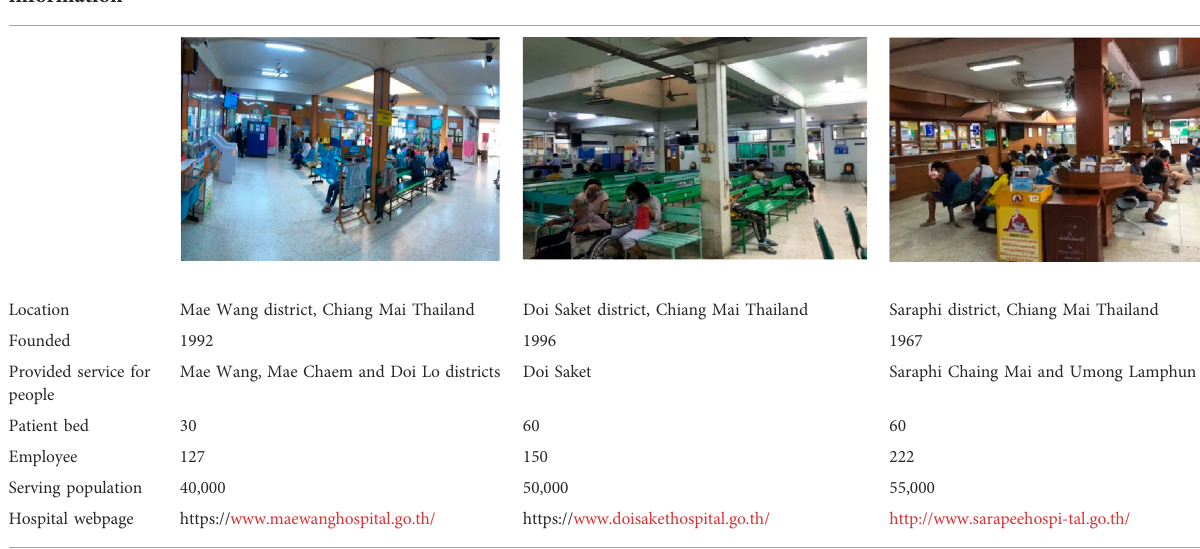
TABLE 1 General overview of the three case description General information